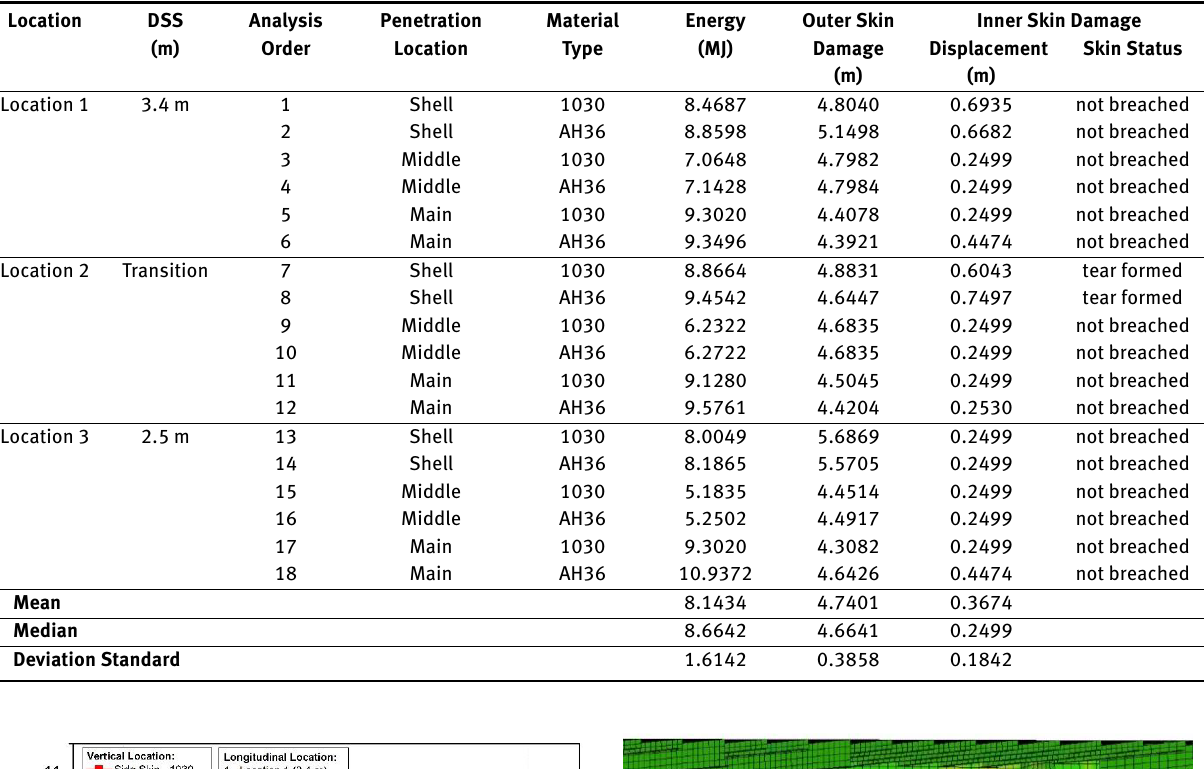
Table 6: Statistical analysis of global results.